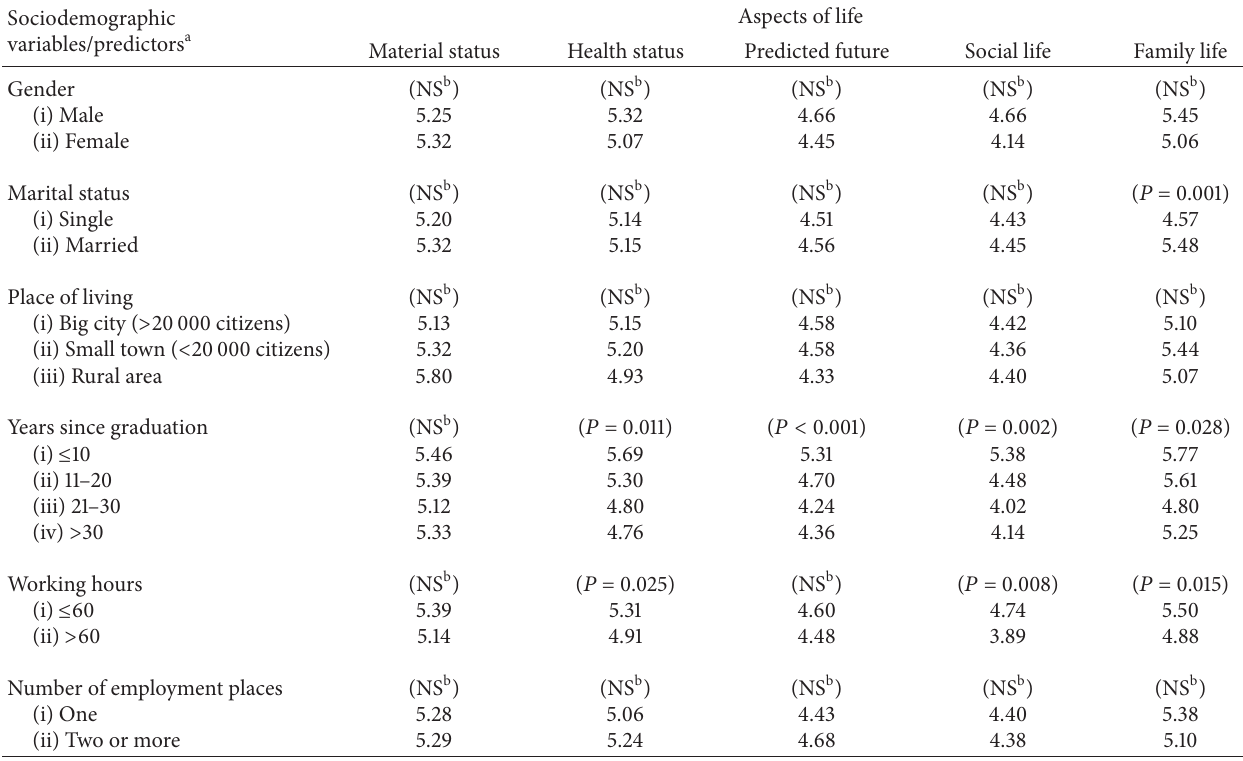
Table 4: Sociodemographic discrete predictors (along with corresponding 𝑃 values) of analyzed aspects of life in surveyed anesthesiologists. Sociodemographic variables/predictors